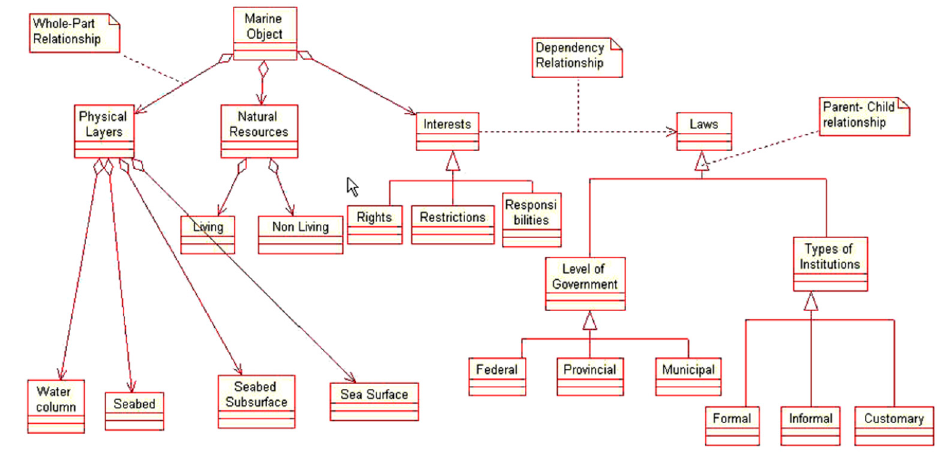
Figure 1. A marine parcel data model [12].